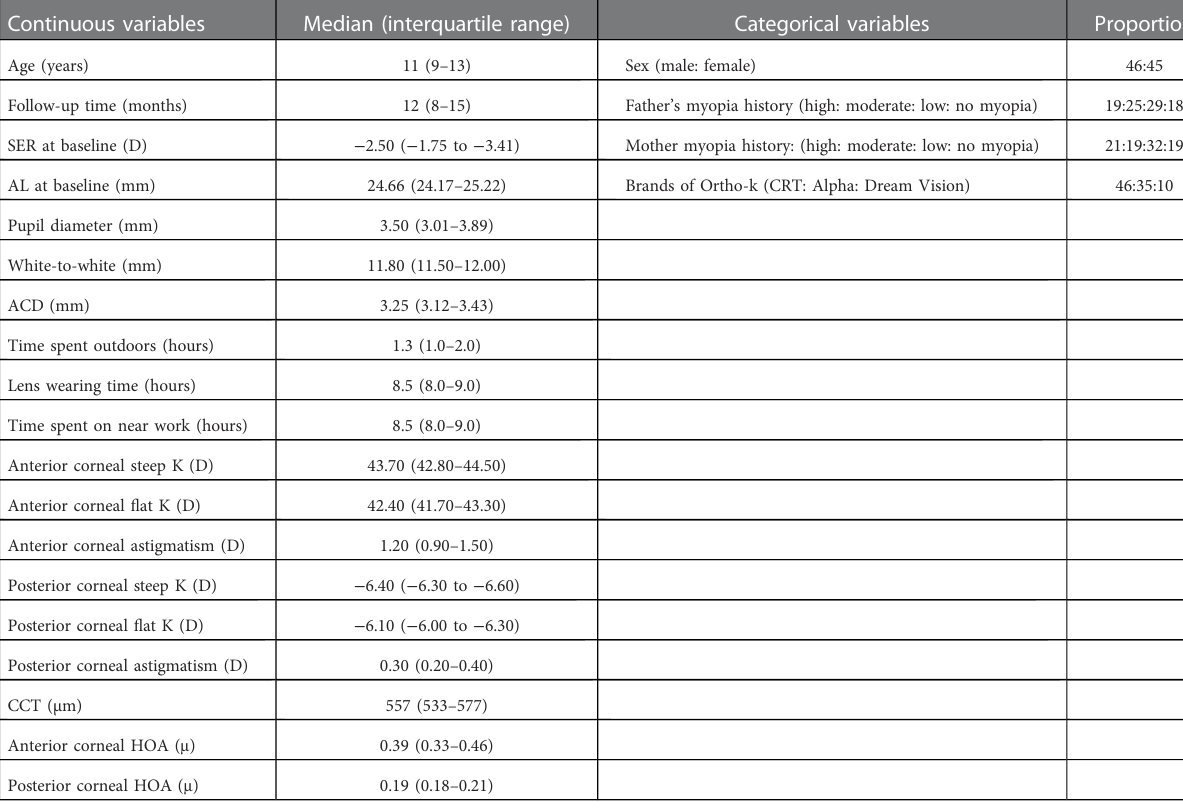
TABLE 1 Demographic, ocular components, and follow-up clinical characteristics of included participants ( n =91). Continuous variables Median (interquartile